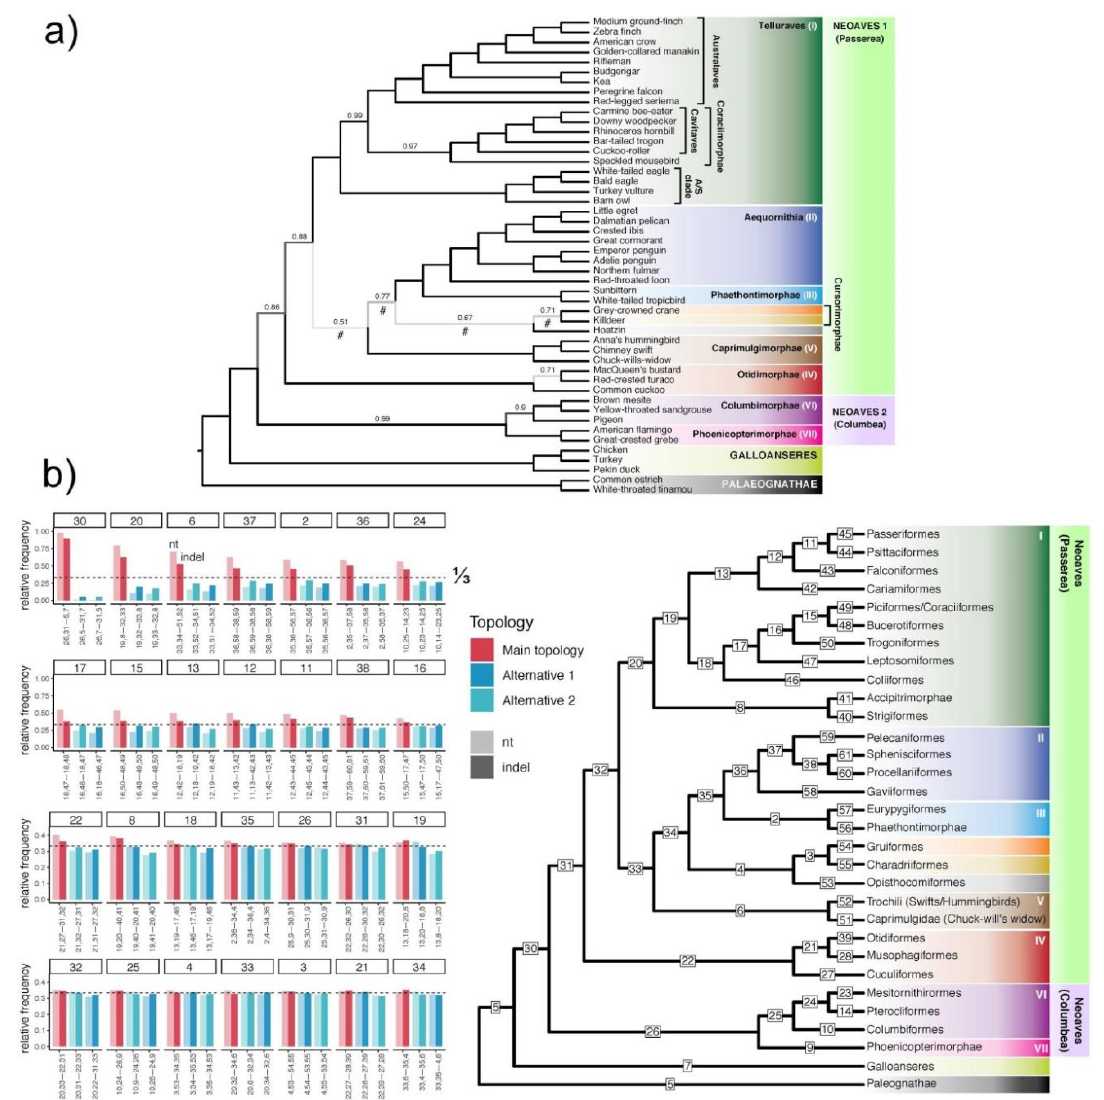
Figure 7. Comparison of quartet frequencies for combined intron+UCE nt+indel gene trees. ( a ) ASTRAL tree using all 12,388 gene trees from combined intron+UCE nt+indel datasets with branches with up to 5% BS contracted. Branch labels are local posterior probabilities (localPP) <1.0. In computing localPP, two gene trees from the same locus are counted as one to avoid double counting the same locus. Branches where the polytomy could not be rejected using the polytomy test in ASTRAL at the 0.05 significance level are marked with a #; ( b ) Right panel: the same tree as above with collapsed branches, and remaining branches labeled 1 to 65; Left panel: quartet frequency of the main resolution (red bar) and the two alternative resolutions around that branch (blue bars) for all labeled internal branches. Labels on the x-axis indicate the quartet topology. For example, for box “37”, the second set of bars puts “36” and “59” together, meaning that the position of pelican and loon are swapped; the third bar puts “58” and “59” together, meaning that loon and pelican ar e put together. Quartet frequencies computed from combined nt gene trees (i.e., UCEs+introns) are shown in lighter tones and quartet frequencies based on combined indel gene trees are shown in darker tones. The horizontal dashed lines show the ⅓ threshold, which corresponds to either a true hard polytomy or random resolutions in gene trees. Nodes with high support (top) and low support (bottom) show two different scales. Note that many of the basal branches have quartet frequencies that are very close to ⅓.